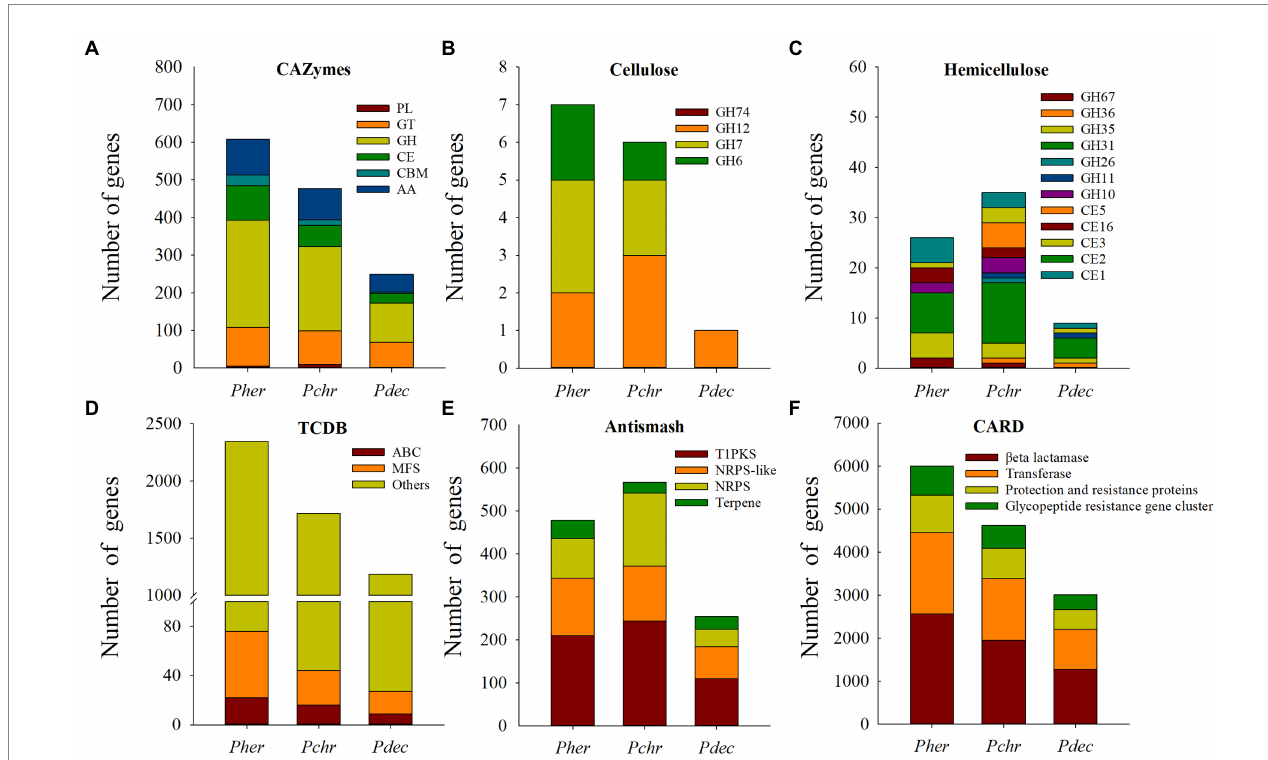
FIGURE 4 Comparison of genes encoding carbohydrate active enzymes (CAZymes) (A–C) and secondary metabolites (D–F) in Penicillum herquei ( Pher ), Penicillium chrysogenum ( Pchr ) and Penicillium decumbens ( Pdec ). (A) CAZymes identified in the genome of Pher , Pchr and Pdec . PL, polysaccharide lyase; GT, glycosyltransferase; GH, glycoside hydrolase; CE, carbohydrate esterase; CBM, carbohydrate-binding module; AA, auxiliary activity. CAZymes involved in cellulose degradation (B) and hemicellulose degradation (C) . (D) Secondary metabolite backbone genes. PKS, polyketide synthase; NRPS, nonribosomal peptide synthetase. (E) Genes encoding transporters. MFS: major facilitator superfamily of transporters, ATP-binding cassette (ABC) transporters. (F) Antimicrobial resistance genes identified in CARD database.